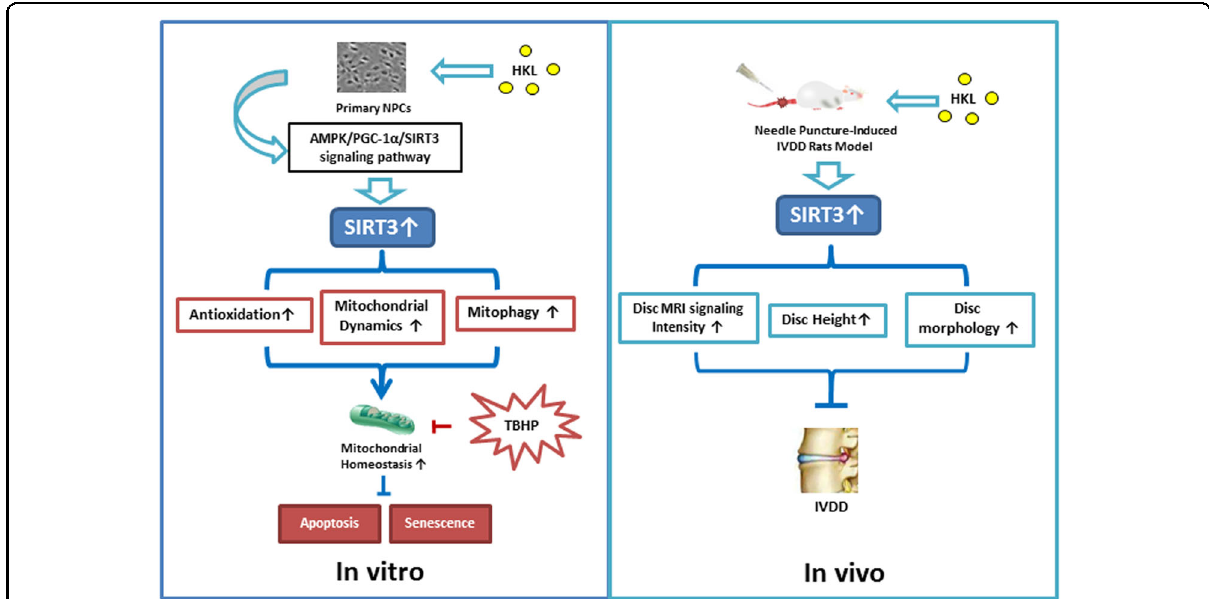
Fig. 8 Schematic of protective effects of HKL on IVDD. In vitro, HKL activates SIRT3 via the AMPK-PGC-1 α signaling pathway to facilitate anti- oxidation, mitochondrial dynamics and mitophagy to prevent mitochondrial dysfunction. By maintaining mitochondrial homeostasis under oxidative stress, HKL downregulates the expression of apoptosis- and senescence-related phenotypes in TBHP-treated NPCs. In vivo, HKL administration promoted the development of IVDD in the rat